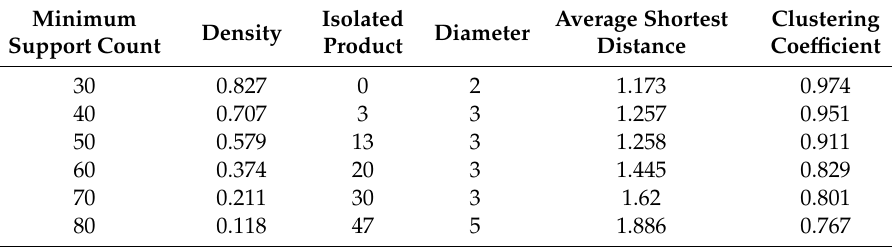
Table 6. Five indexes under di ff erent minimum support count in